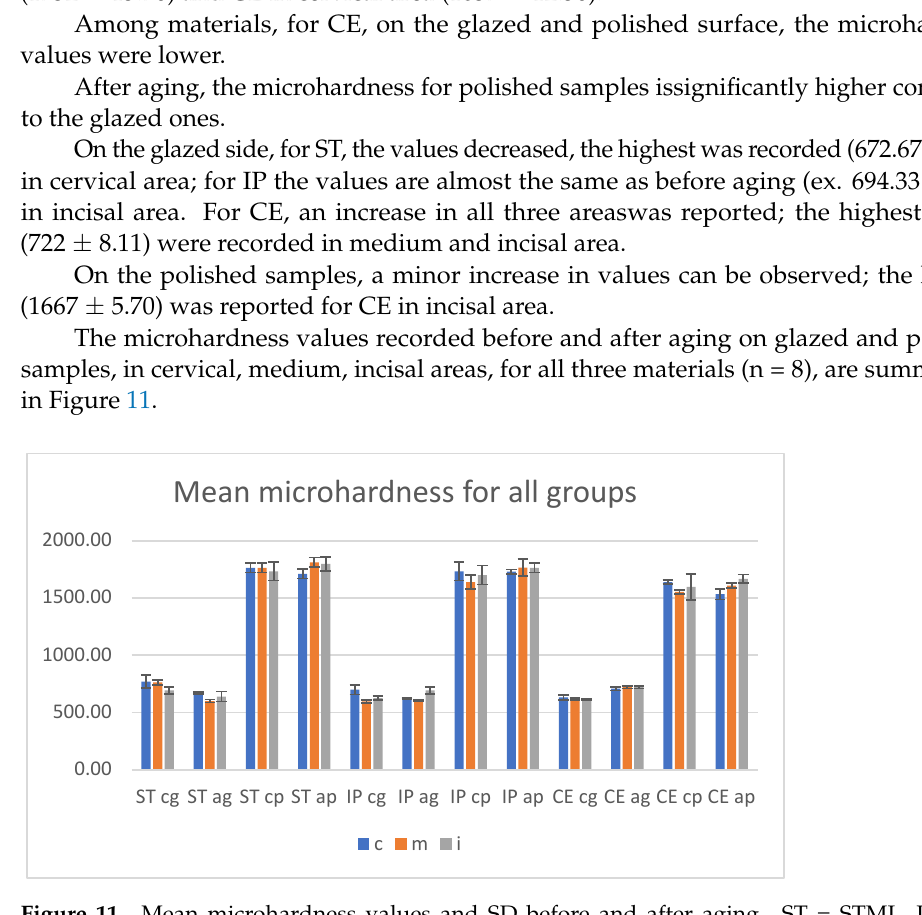
Figure 11. Mean microhardness values and SD before and after aging. ST = STML, IP = IPS e.maxZirCAD CEREC/in Lab MT Multi, CE = CeramillZolidfx ML; cg = control glazed, cp = control polished, ag = aged glazed, ap = aged polished;c = cervical, m = medium, i = incisal. Before aging, the microhardness values for polished specimens were significantly